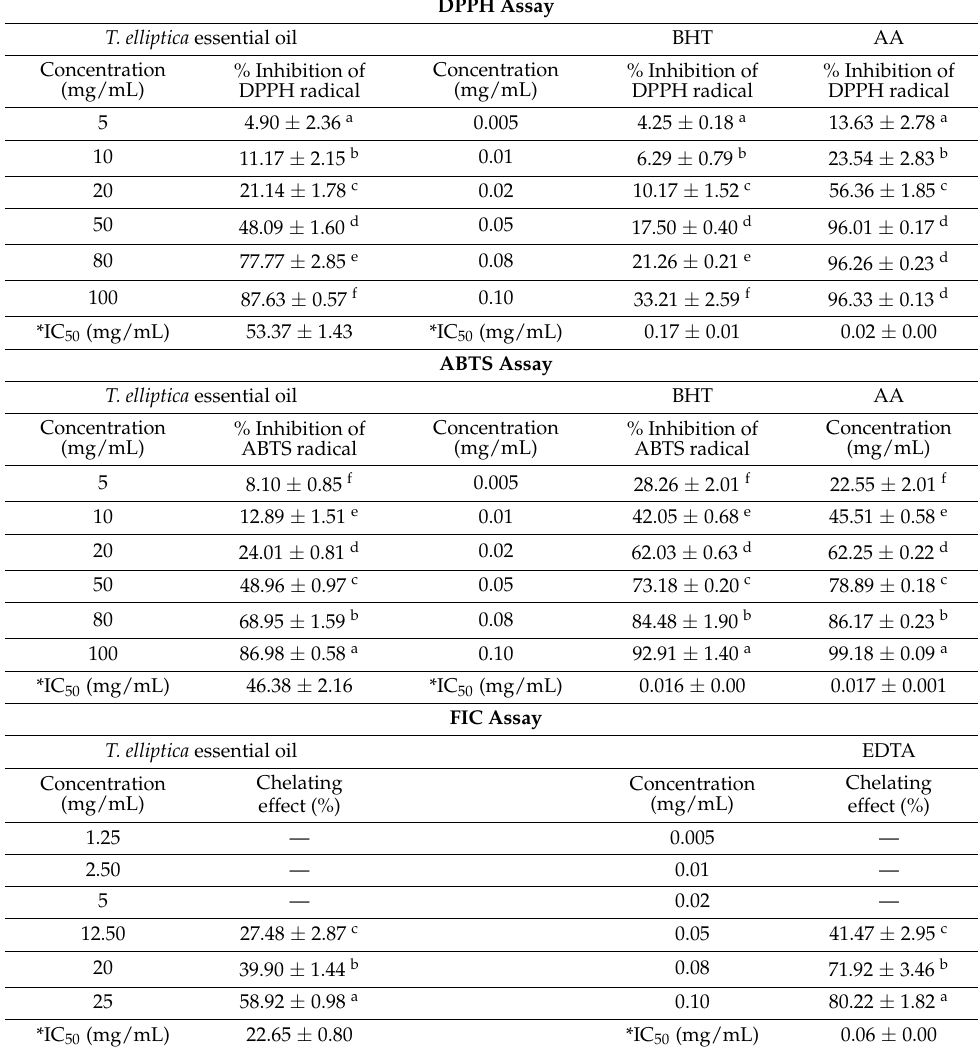
Table 2. Antioxidant activity of T. elliptica essential oil measured by DPPH, ABTS and FIC assays. DPPH Assay T. elliptica essential